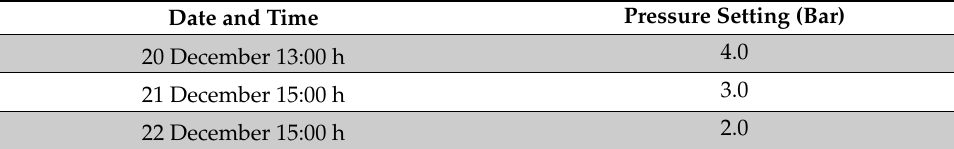
Table 2. Time setting of pressure within the analysis.